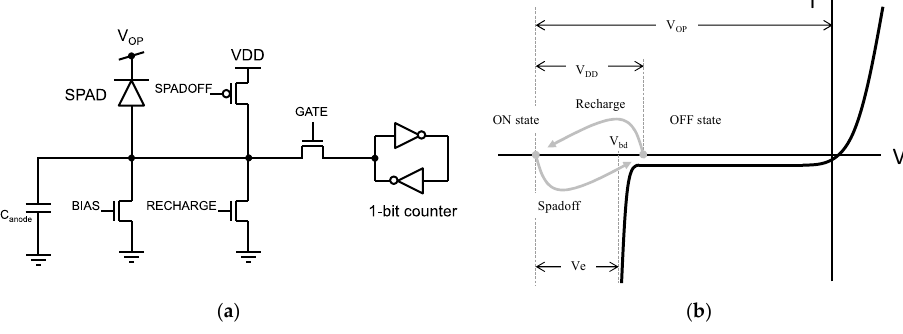
Figure 2. Pixel architecture. ( a ) SPAD configuration with parasitic load (C anode ); the MOS transistors controlled by signals “SPADOFF”, “GATE”, and “RECHARGE” act as switches that implement gating. The quenching transistor controlled by “BIAS” acts as a non-linear resistor used for quenching. The one-bit counter (represented here as a simplified latch) is used to record photon detection; ( b ) I-V characteristics of the SPAD pixel. In the ON state, the SPAD is biased above breakdown (V bd ) by a voltage known as excess bias (V e ). When “SPADOFF” is activated, the SPAD bias is pushed below breakdown; “GATE” is deactivated to isolate the counter; this is the OFF state. To bring the SPAD back to the ON state, “GATE“ is activated, “SPADOFF“ is deactivated, and “RECHARGE“ is activated for a short time, typically nanoseconds, thereby bringing the bias to the initial state above breakdown. Photon detection triggers a similar cycle with a resulting change of state of the one-bit counter from “L“ to “H“.